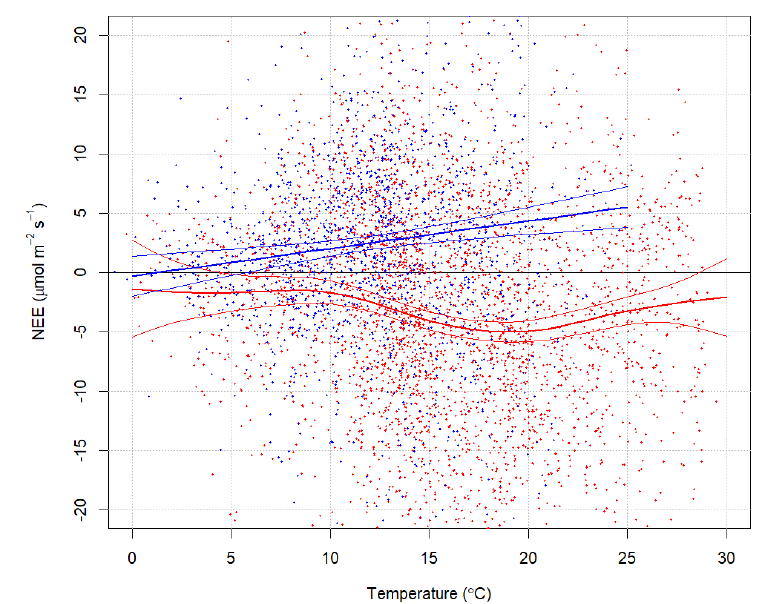
Figure 4. NEE (µmol m −2 s −1 ) and temperature (°C) over the study period (2014). Blue dots represent nighttime and red dots daytime eddy flux measurements. Lines represent GAM model predictions with confidence intervals. Table 2. Average monthly and seasonal values of NEE ( µ mol m − 2 s − 1 ), standard deviations (SD), and data points over the study